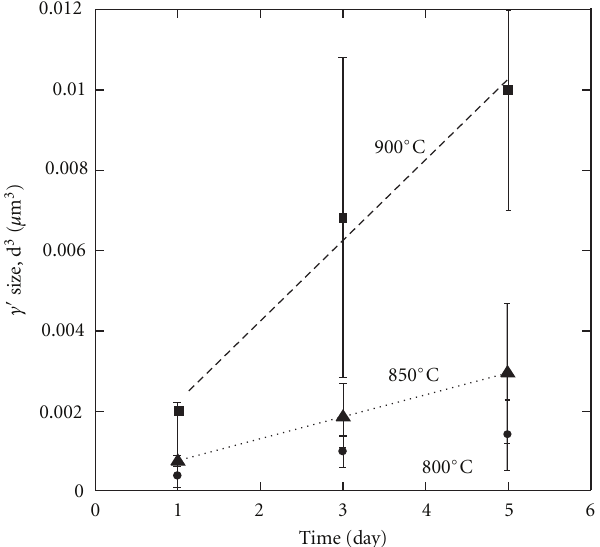
Figure 7: Cube of γ (cid:2) precipitates size versus annealing time at 800 ◦ C, 850 ◦ C and 900 ◦ C for Ni-15at%Al (MA). Table 4: Activation energy Q (kJ/mol) of atomic di ff usion derived from growth rate of γ (cid:2) precipitates.